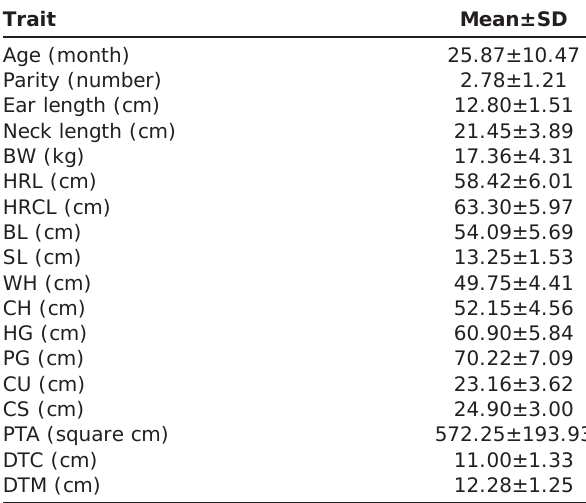
Table-3: Descriptive statistics for different body linear traits including age, parity in Indian Black Bengal goats.